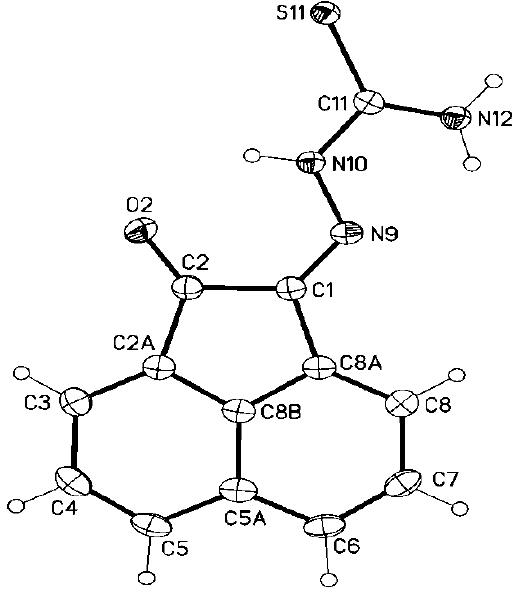
Figure 1. Molecular structure of one of the two crystallographic independent molecules of 5a (displacement parameters are drawn at 50% probability level).